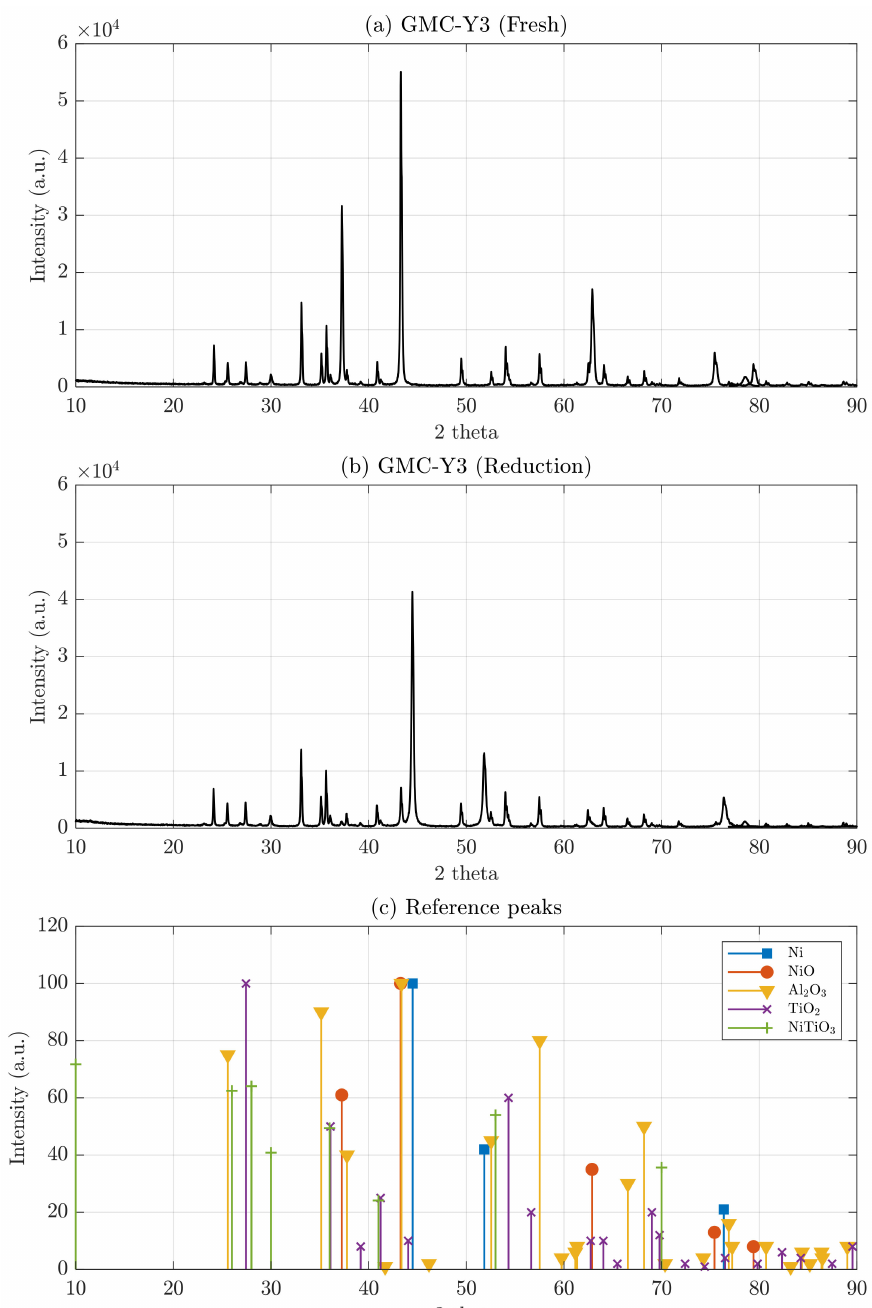
Figure 3. X-ray diffraction patterns of GMC-Y3 catalysts: ( a ) fresh, ( b ) after reduction and ( c ) refer- ence